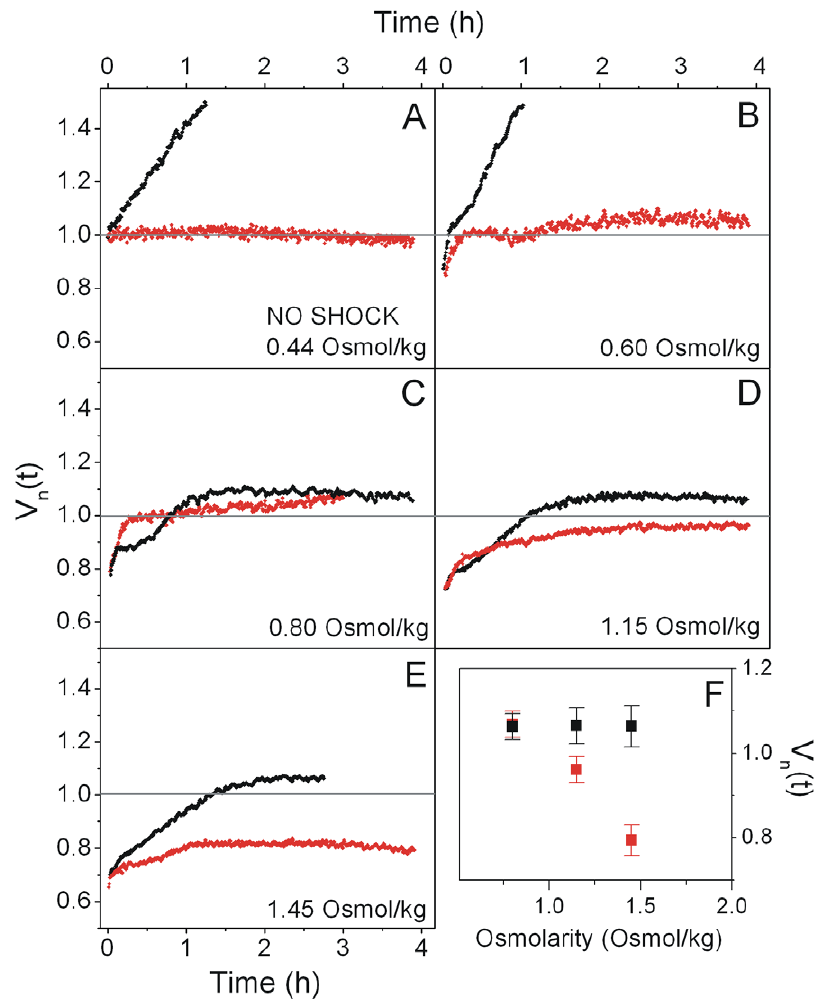
Figure 5. Slow recovery requires protein synthesis. (A)–(E) Averaged recovery traces shown for different shock magnitudes (V n (t)). For each shock, the recovery trace in the presence (red) and absence (black) of the drug chloramphenicol is shown. Data was recorded and analyzed as in Figure 3. 0.44 Osmol/kg (no shock, N=10), 0.6 Osmol/kg (N=5), 0.8 Osmol/kg (N=5), 1.15 Osmol/kg (N=20) and 1.45 Osmol/kg (N=10). (F) Final volume, calculated as the average of the last 15 minutes of data in (A–E), versus shock magnitude. Error bars are standard error of the